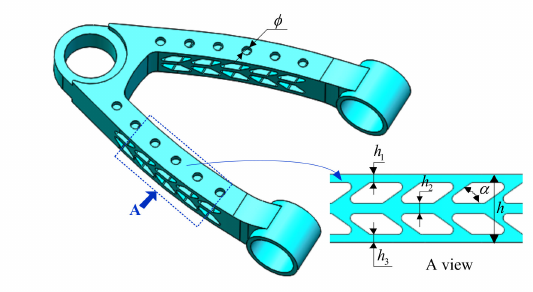
Figure 14. Parametric model of the control